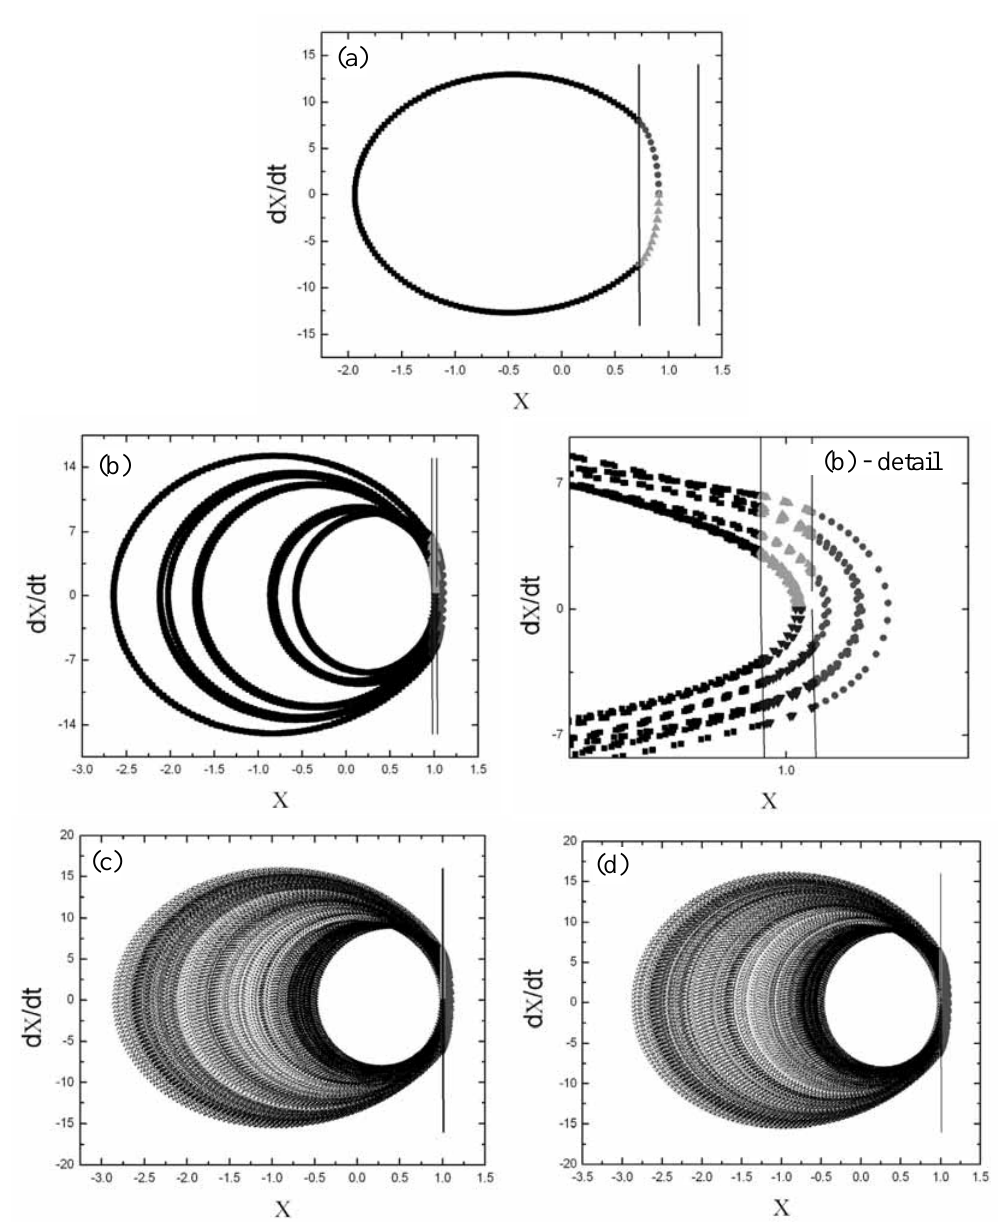
Fig. 4. Analysis of different narrow band thickness. (a) η = 2.8 × 10 − 1 ; (b) η = 2.8 × 10 − 2 ; (c) η = 2.8 × 10 − 3 ; (d) η = 2.8 × 10 − 4 . shows numerical simulations for η = 2.8 × 10 − 1 , η = 2.8 × 10 − 2 , η = 2.8 × 10 − 3 and η = 2.8 × 10 − 4 . Notice that different qualitative responses are obtained due to the improper choice of the parameter η . When, η = 2.8 × 10 − 1 , the system does not pass to the region Γ + since this value is not small enough. The decrease for a value η = 2.8 × 10 − 2 , still presenting numerical problems due to the same reason (observe the enlargement of this region showing an orbit that does not reach the region Γ + ) . On the other hand, when the thickness of the narrow band is smaller than η = 2.8 × 10 − 3 , the system passes for all four regions, obtaining the expected result. Figure 4 presents simulations for η = 2.8 × 10 − 3 and η = 2.8 × 10 − 4 showing the same result. Based on this conclusion,